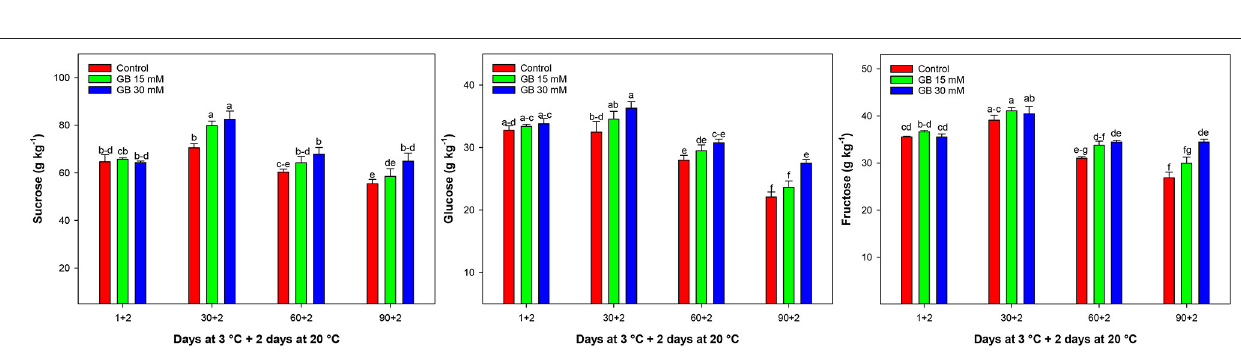
FIGURE 3 | Changes in sucrose, glucose, and fructose in control and GB-treated fruit of “Moro” blood orange at 3 ◦ C. Different letters and vertical bars show a significant difference ( p < 0.05) and standard errors ( ± SE) of means, respectively.